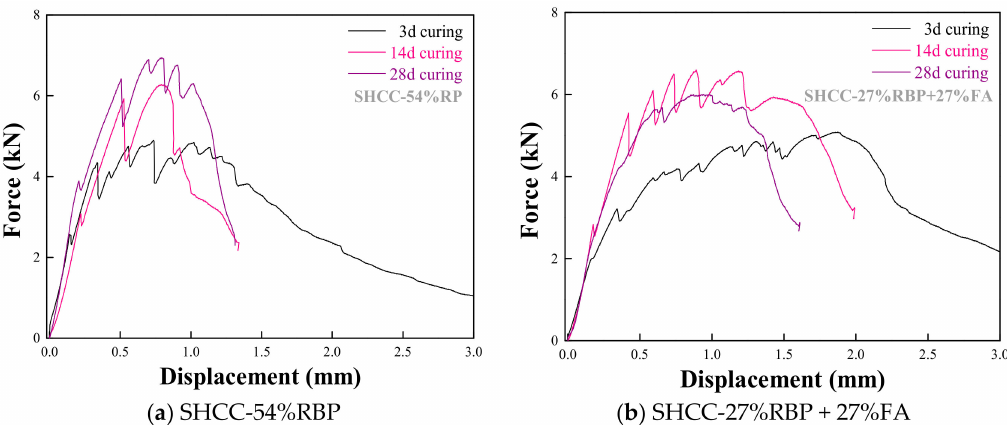
Figure 14. Force-displacement curves of SHCC with RBP and FA after various curing days. ( a ) SHCC-